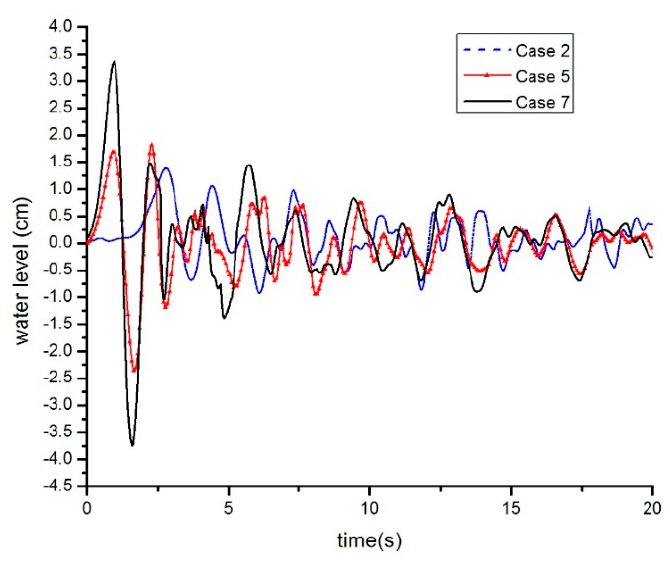
Figure 14. Water level at point 2.